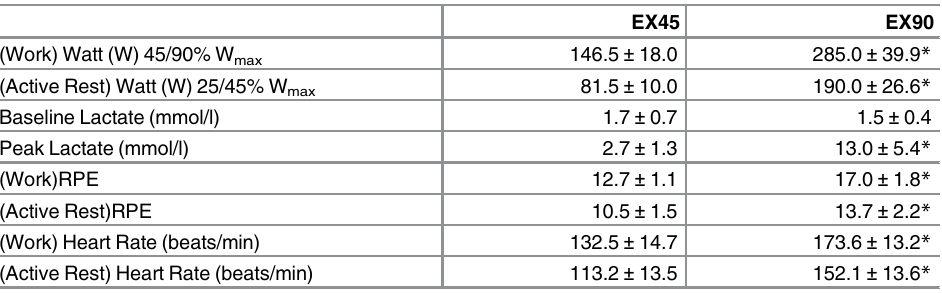
Table 3. Exercise